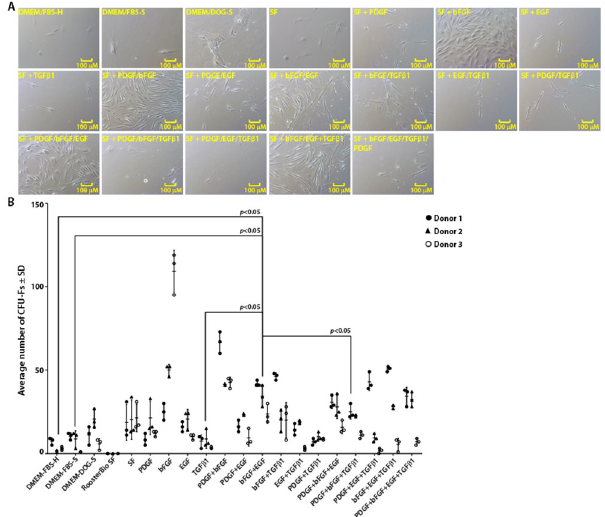
Fig 4. Identification of growth factors required for colony formation by canine Ad-MSCs under serum-free conditions. A . Photomicrographs of canine Ad-MSC colonies cultured in serum-free medium with or without growth factors or DMEM/FBS-H or DMEM/FBS-S or DMEM/DOG-S. B . Scatter plot of CFU-Fs for canine Ad-MSCs in serum-free medium with or without growth factors or DMEM/FBS-H or DMEM/FBS-S or DMEM/DOG-S. CFU-Fs were enumerated 21 days later. Means of three replicates for each donor are